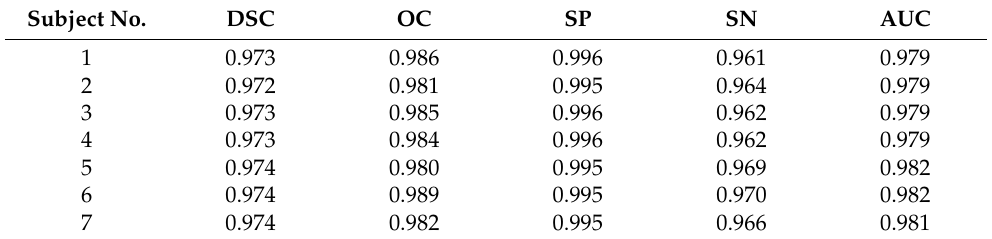
Table A8. Evaluation results for cerebellar tissue with fissures (model M2) on BrainWeb dataset.